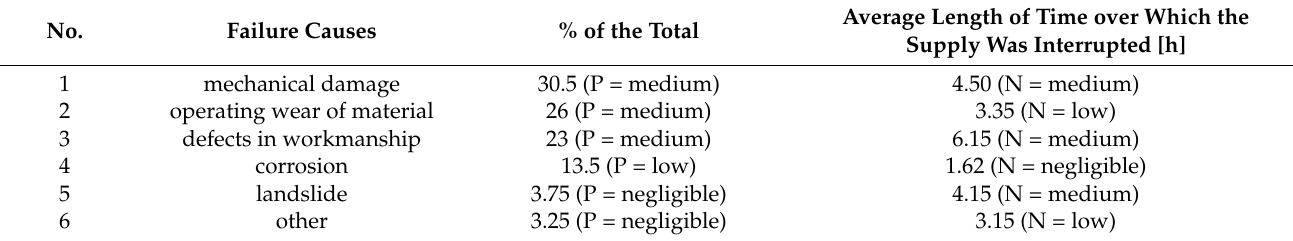
Table 1. Causes of failures through the gas-supply network.